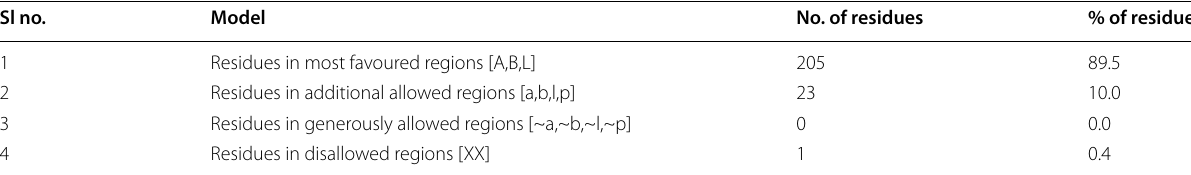
Table 4 Ramachandran plot statistics